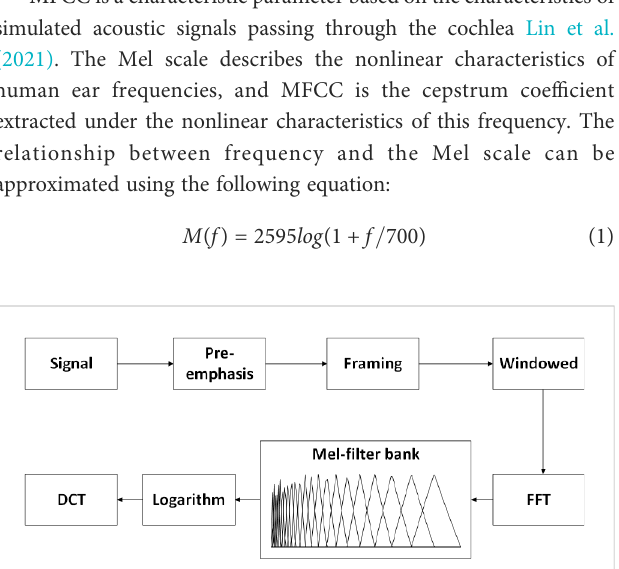
FIGURE 3 MFCC algorithm fl ow chart.